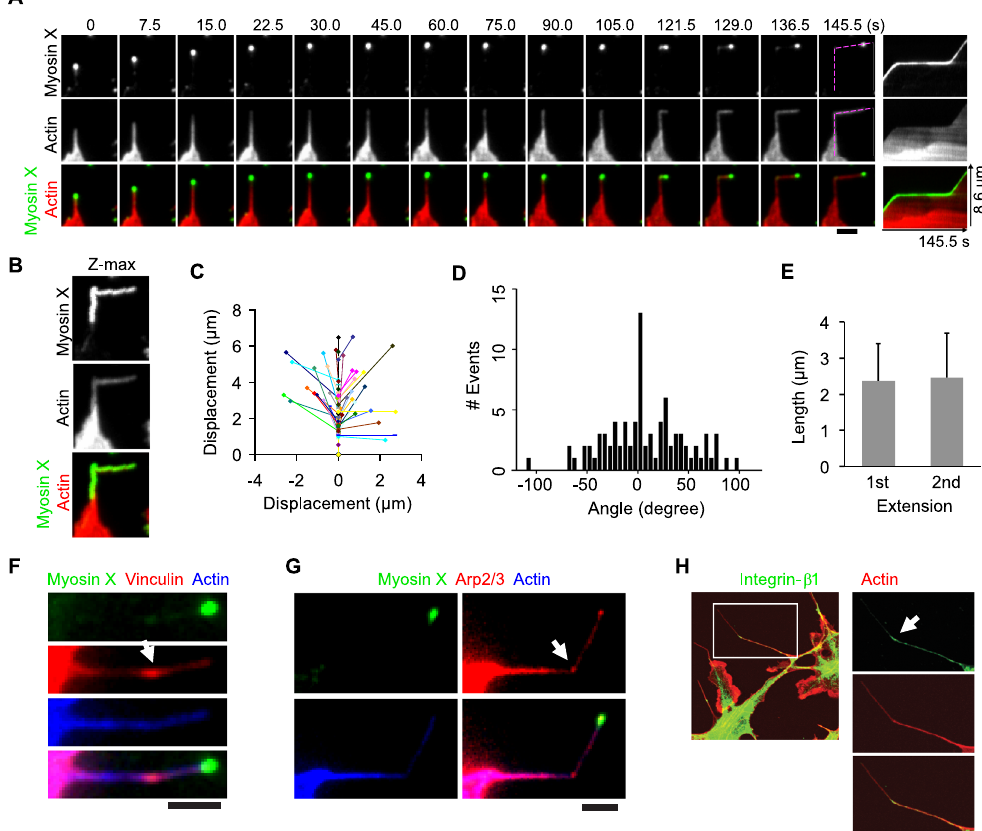
Figure 5. The multi-cycle extension and directional changes during filopodia extension. ( A ) Time-lapse montages of EGFP-myosin X and mCherry-actin show a directional change during the multi-cycle extension of filopodia. The corresponding kymographs of myosin X and actin along filopodial extension (purple dashed lines) are shown. The maximum intensity projections of EGFP-myosin X and mCherry-actin are shown in ( B) . ( C ) The representative line traces show the displacements and directional changes during filopodia extension, with the three nodes for each line representing a filopodia’s initiation, length at the end of the first extension, and position at the end of the second extension. ( D ) Histograms of the angle changes between the first and second cycle of filopodia extension (n = 85). ( E ) Average length ( ± s.d.) of the filopodial extension during the first and second cycle of extension (n = 85). ( F and G ) Local accumulation of vinculin-tomato and mCherry-Arp2/3 at sites where directional changes occured (arrows). ( H ) Localization of integrin- β 1 in myosin X-induced filopodia. The cells expressing myc-myosin X were stained with antibodies against integrin- β 1 followed by the Alexa Fluor 488-conjugated secondary antibody. Actin was stained using the Alexa Fluor 633-conjugated phalloidin. The arrow points to the local accumulation of integrin- β 1 at the site where the directional change occurred. Scale bars, 2 μ